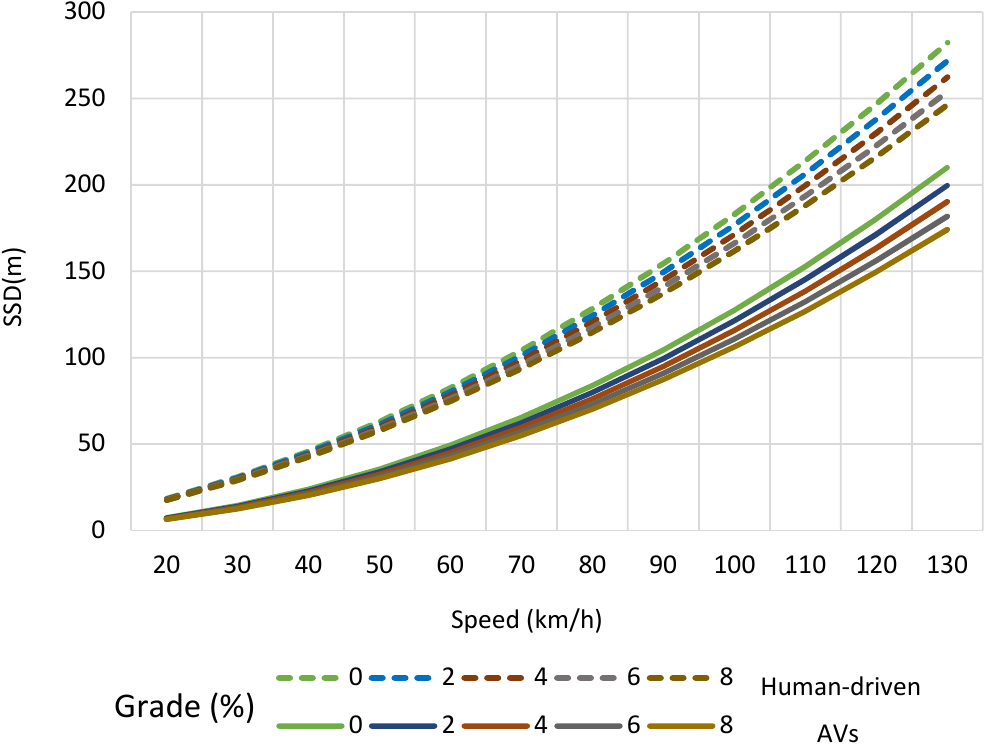
Figure 2. SSD for different upward grades for both human-driven vehicles and AVs.